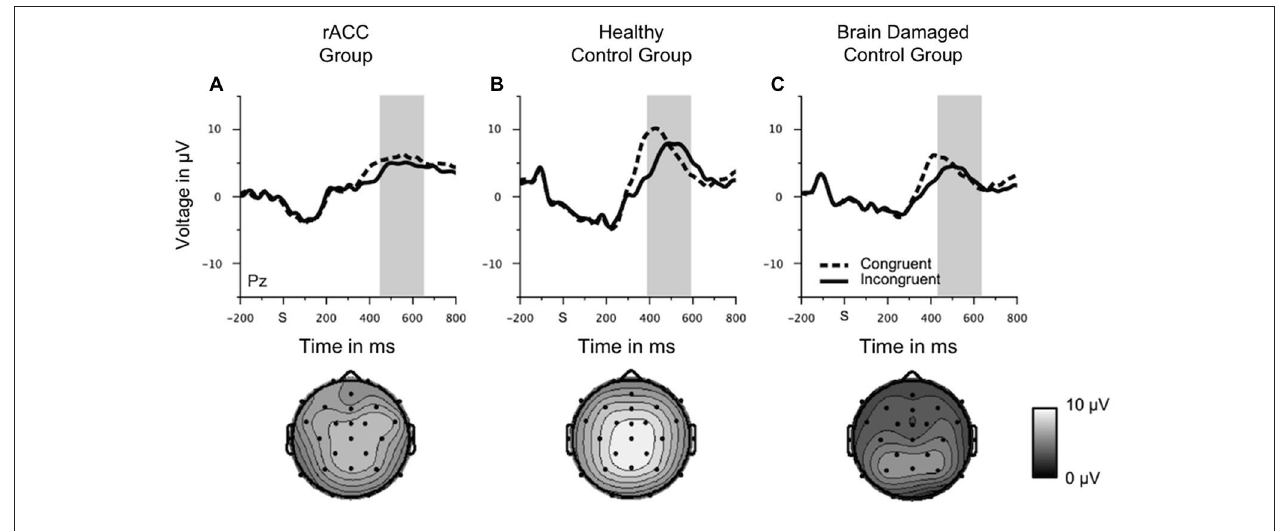
rostral anterior cingulate cortex (rACC Group, A ), in healthy controls (HC Group, B ), and in patients with brain lesions outside the frontal lobes (BDC Group, C ). S = time point of stimulus onset; µ V = microvolt; shaded areas correspond to the time windows used for statistical